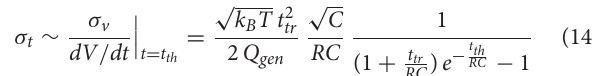
for R & 60 (cid:127) . To have some margin over the noise,